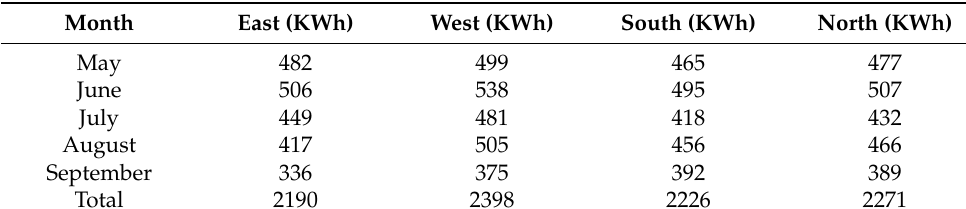
Table 6. Solar radiation during the summer by building orientation.